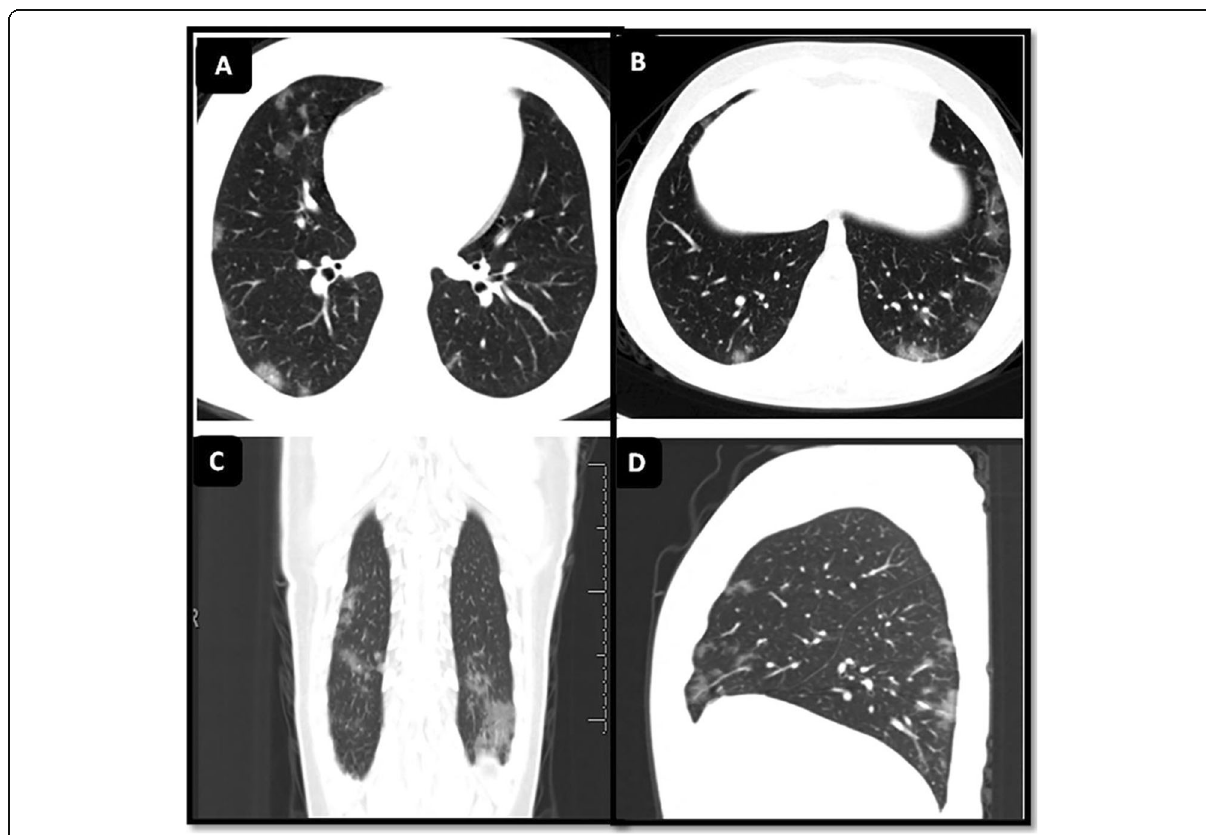
Fig. 7 A male patient aged 8 years old with AML and under chemotherapy developed a COVID-19 infection and presented with fever and cough. Chest CT revealed multiple bilateral peripherally located ground-glass opacities; chest CT severity score was